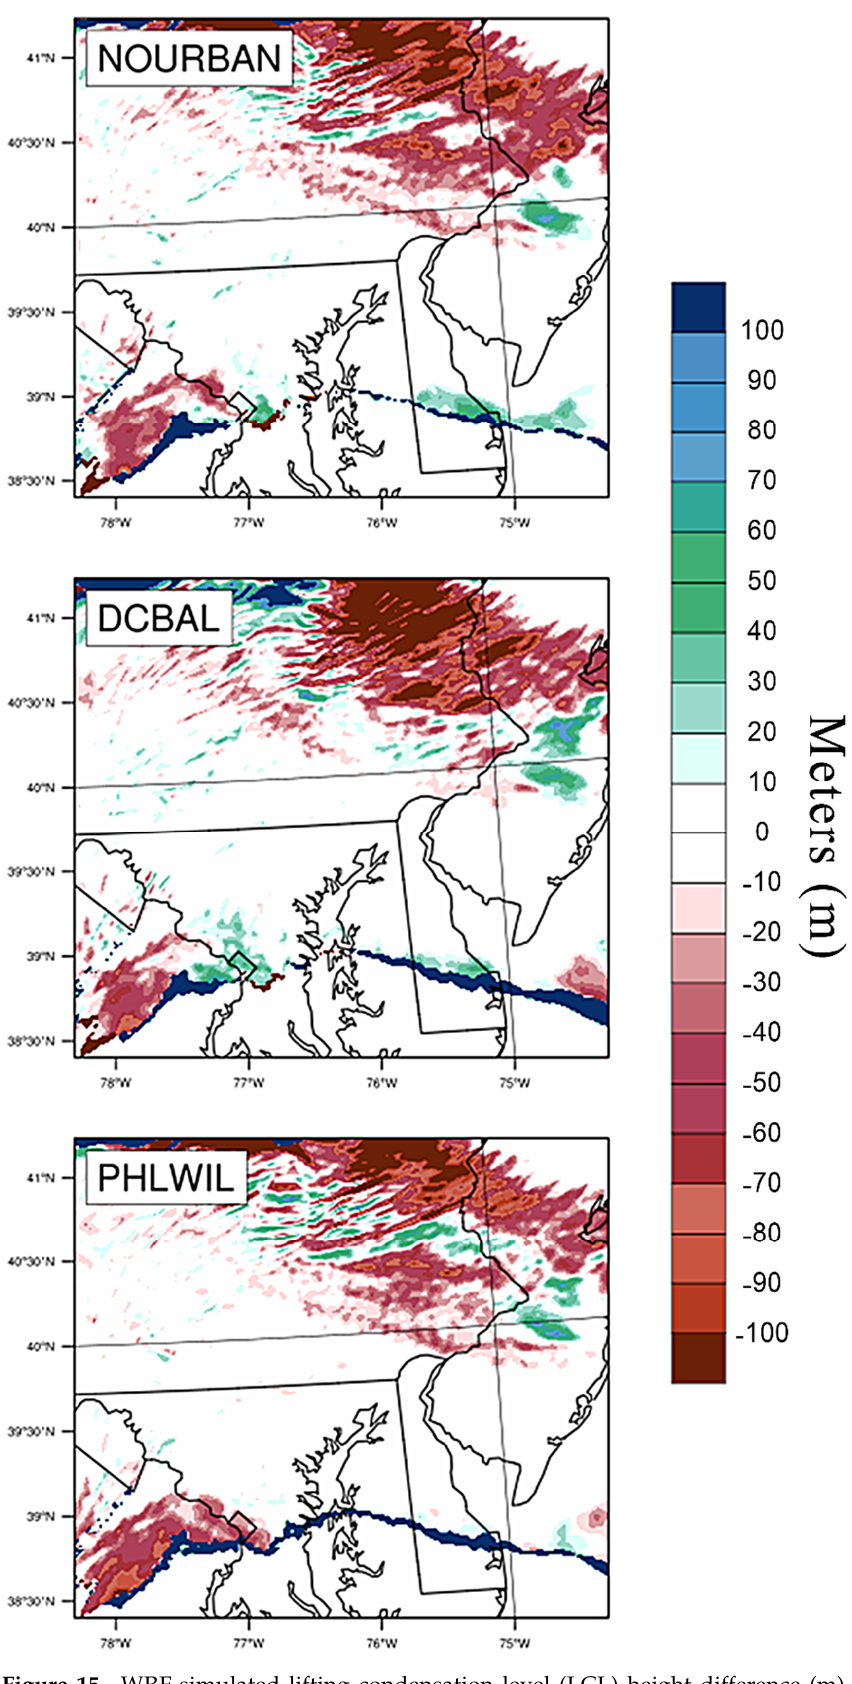
Figure 15. WRF-simulated lifting condensation level (LCL) height difference (m) from control (LCL modified -LCL control ). Valid at 1200 UTC on 6 February 2004.